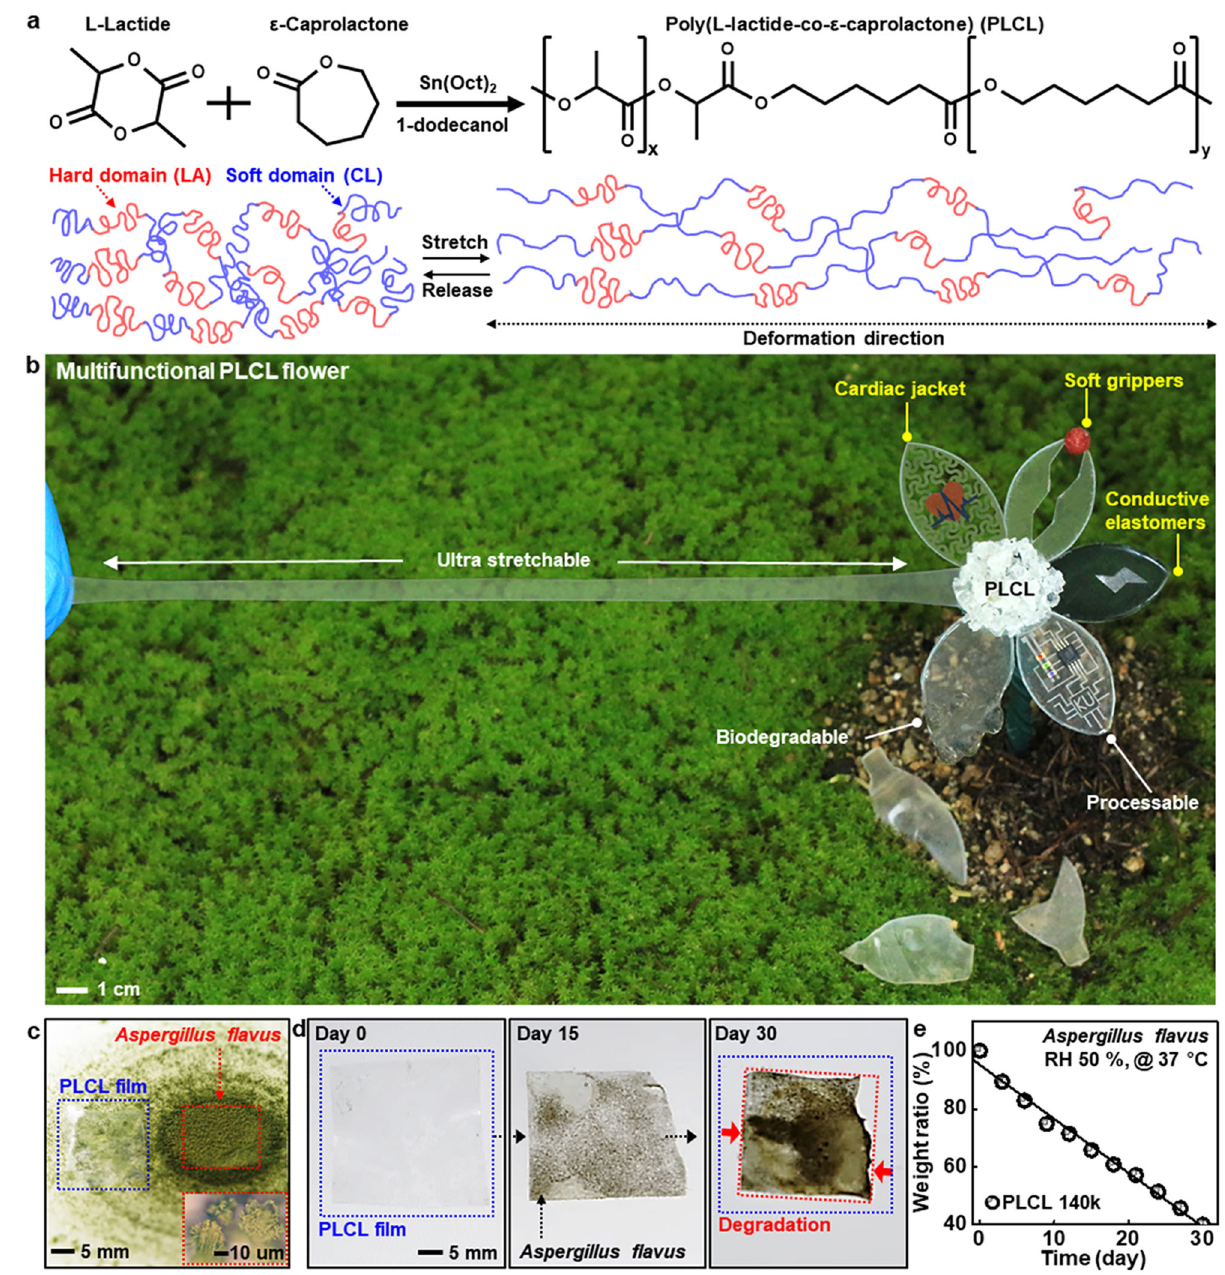
Fig. 1 | Highly stretchable, processable, biodegradableelastomersfor versatile applicationsoftransientelectronics.a Molecularstructureofpoly(L-lactide-co- ε - caprolactone) (PLCL) elastomer synthesized from biocompatible/biodegradable cyclicesters,L-lactideand ε -caprolactone,andproposedmechanismforreversible chain motions during tensile stretching. b PLCL elastomer-based arti fi cial fl